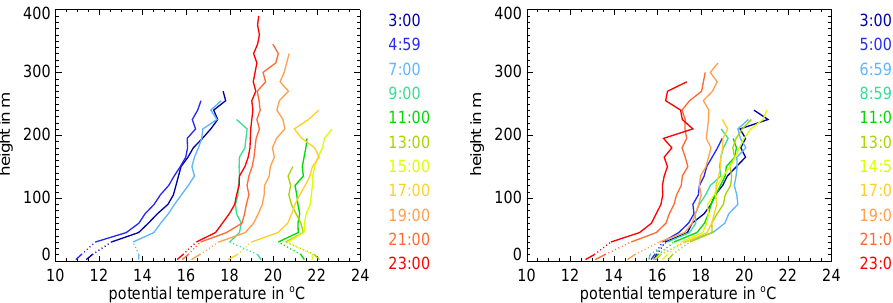
Fig. 10. Development of potential temperature profiles over 24h at Jesenice on 21 September 2006 (left) and on 24 October 2006 (right). Figure10:Developmentofpotentialtemperaturepro(cid:28)lesover24hatJeseni eon21September2006(left)andon